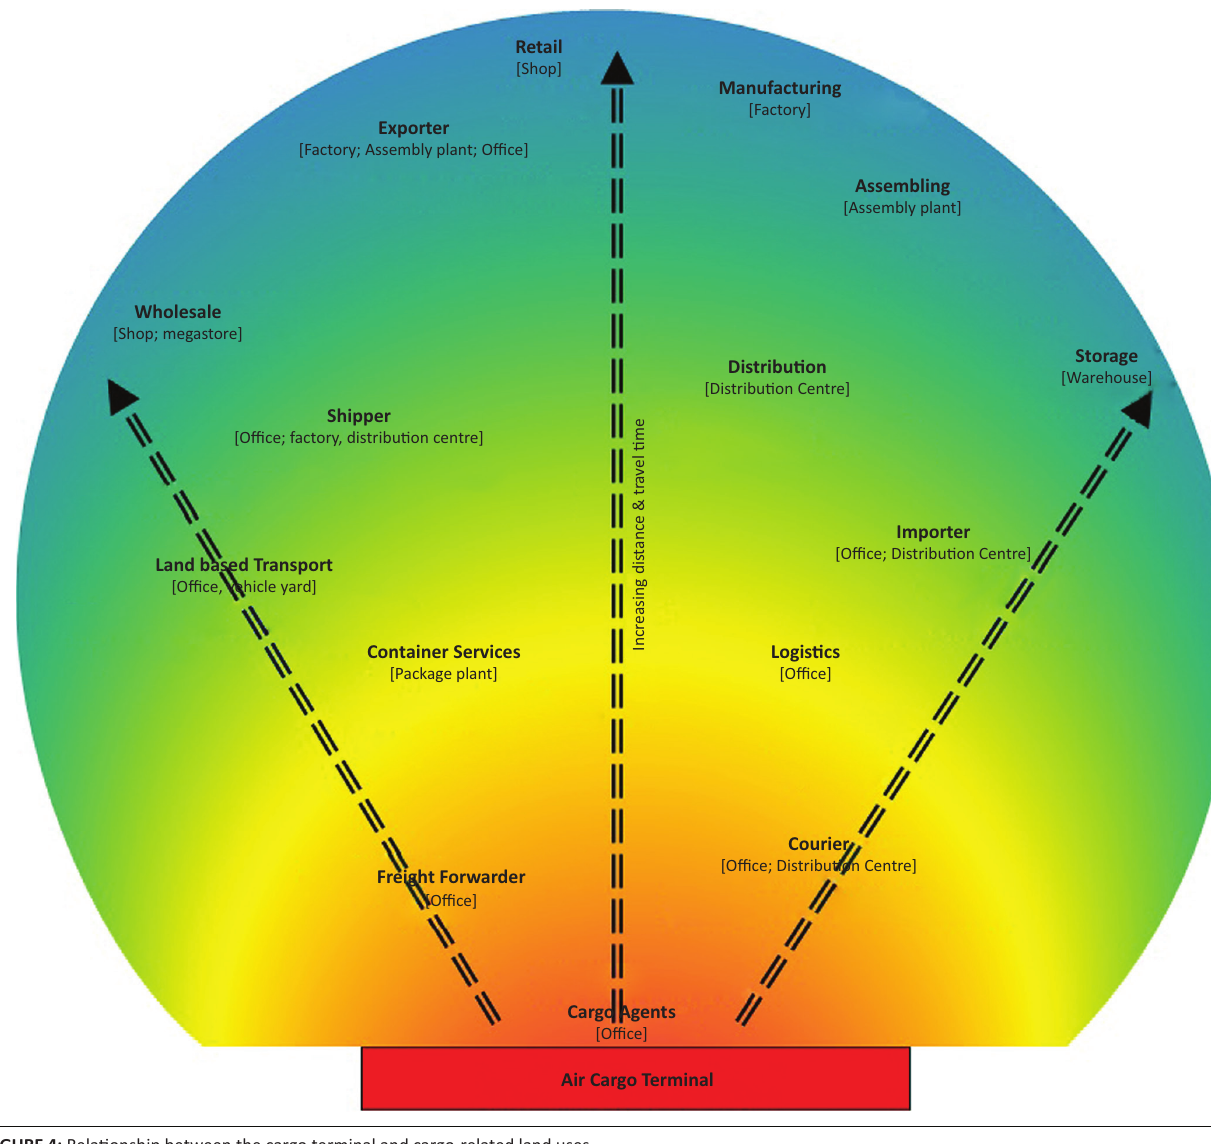
FIGURE 4: Relationship between the cargo terminal and cargo-related land